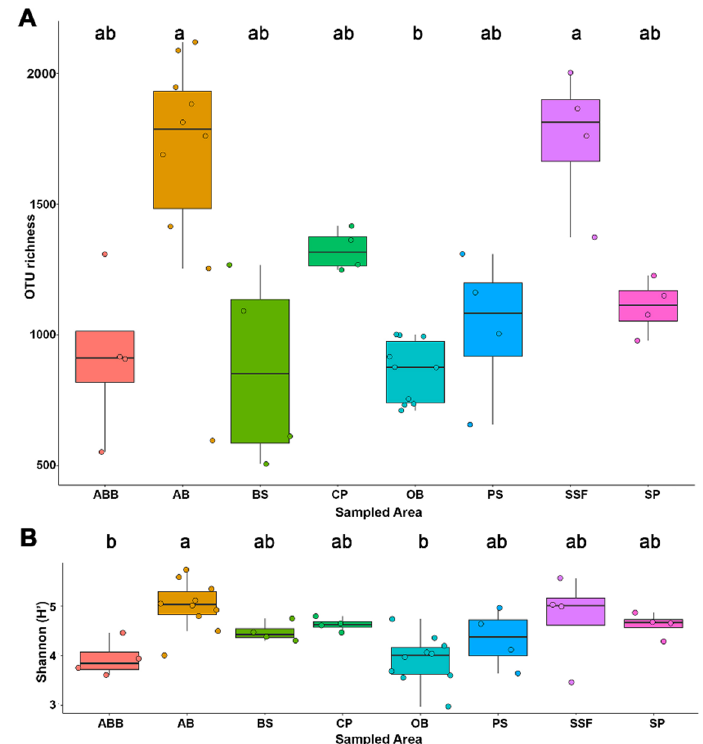
Figure 3. Boxplot showing richness ( A ) and Shannon index diversity for each habitat ( B ). ABB = abandoned rural building; AB = armadillos’ burrows; BS = Brazilian savanna; CF = coffee plantation; OB = owls’ burrows; PS = pasture; SSF = seasonal semi-deciduous forest; SP = sugarcane plantation. Different letters are significantly different at Dunn (richness) and Tukey tests (Shannon index), p < 0.05. Table 1. ANOVA, Kruskall–Wallis and PERMANOVA tests for diversity (H (cid:48) ), fungal richness (S) and fungal communities in different environments. A posteriori test for pairwise comparison between the sampled environments. ANOVA * and Pairwise PERMANOVA Kruskall–Wallis *